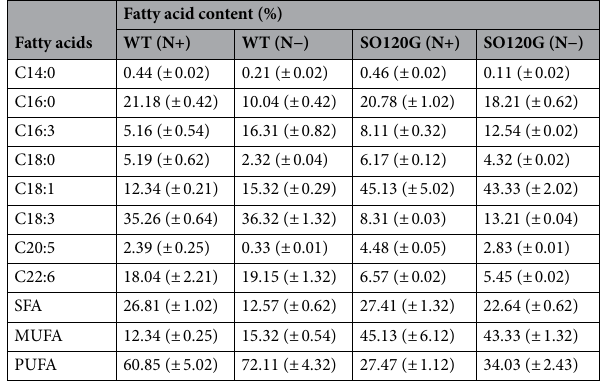
Table 3. Fatty acid profiles of lipids derived from the WT and SO120G samples under N+ and N− cultivations. Values are mean (± SD) of n = 3 cultivations per treatment.